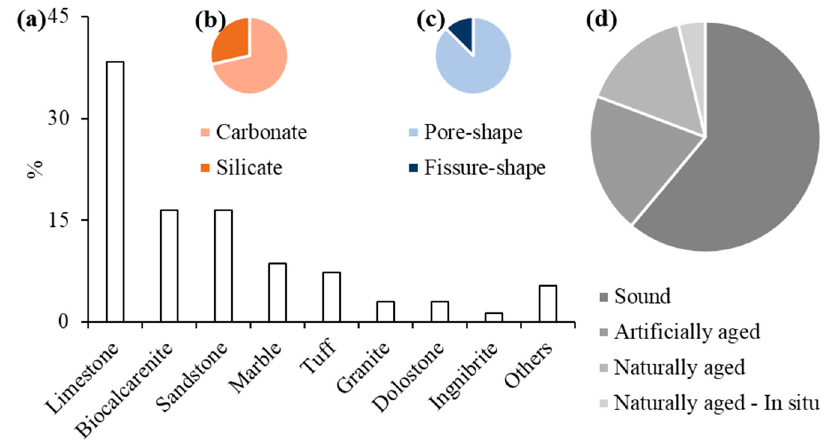
Figure 2. Distribution of stone varieties used in stone consolidation research according to lithotype ( a ), mineralogical nature ( b ), type of void shape ( c ), and condition ( d ).